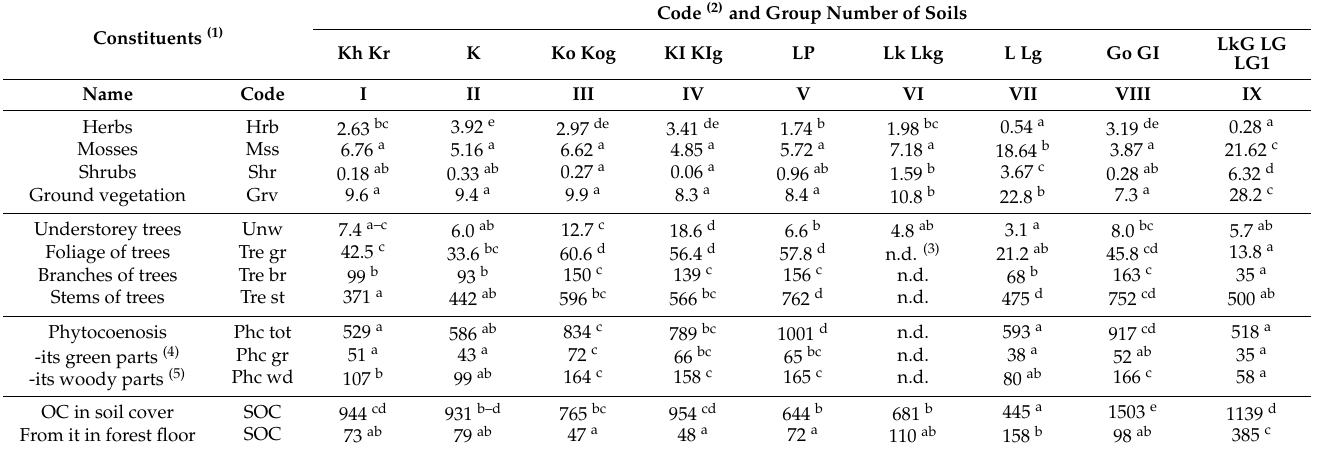
Table 3. Areal densities of organic carbon (10 − 1 Mg OC ha − 1 ) in aboveground phytomass (PM) and soil cover of different forest ecosystems’